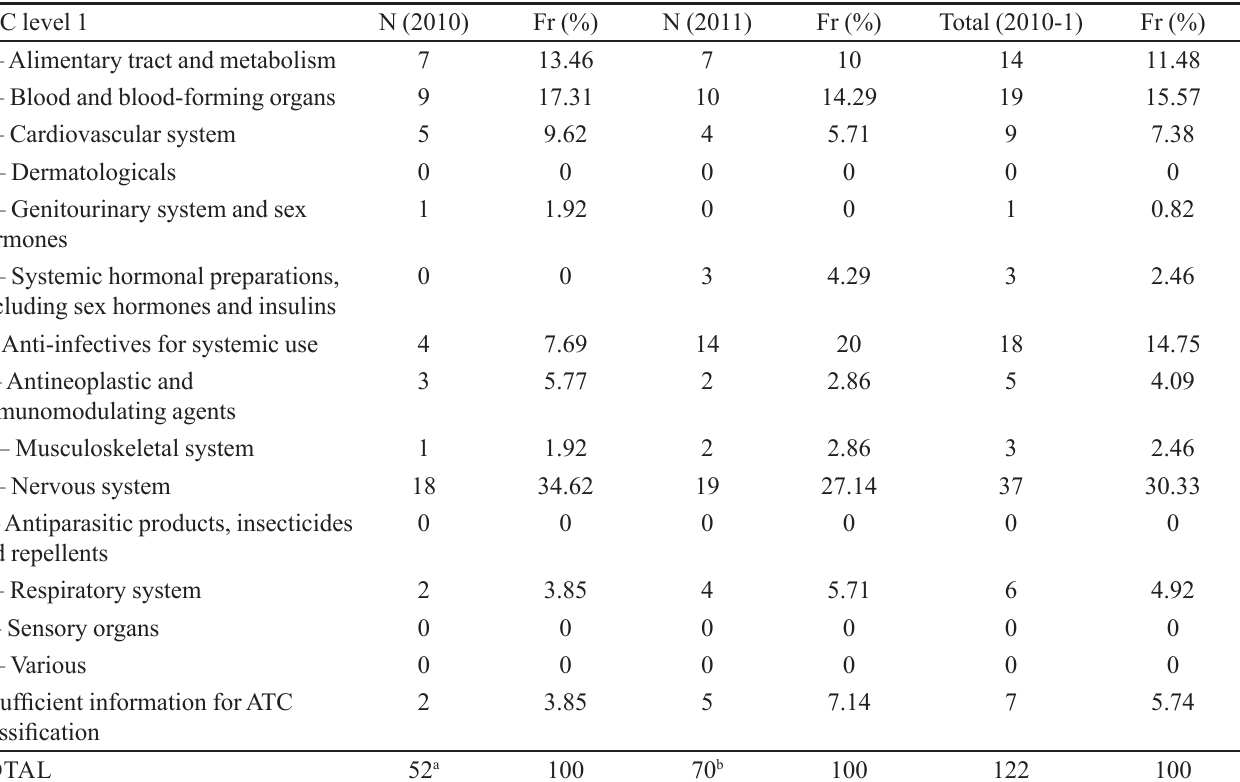
TABLE III - Drugs involved in medication error reports according to the Anatomical Therapeutic Chemical Classification